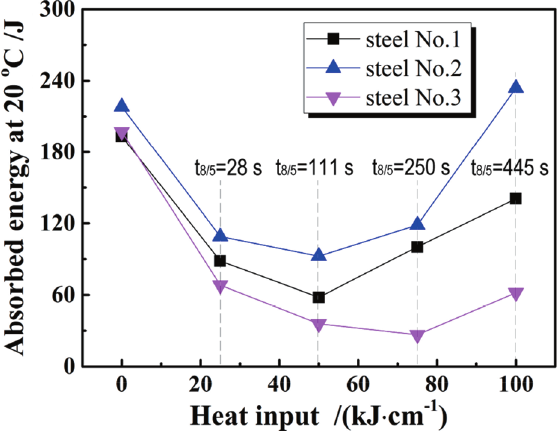
Figure 8: The microstructure of the heat affected zone in steel No.2 after the welding process with t 8/5 is